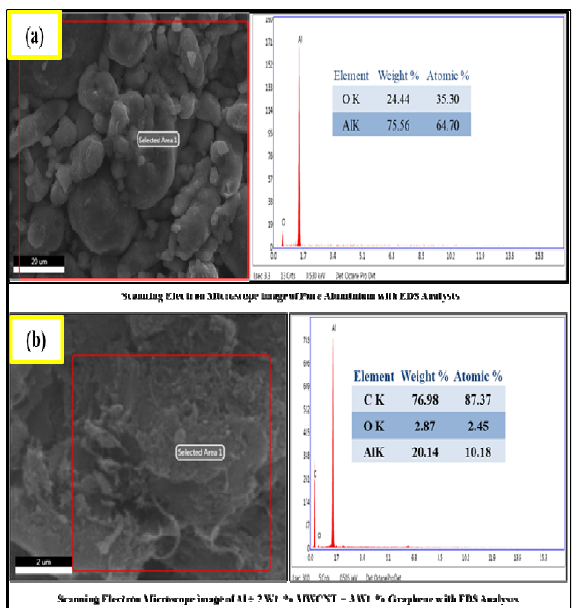
Figure 8. EDS image of (a) AL and (b)